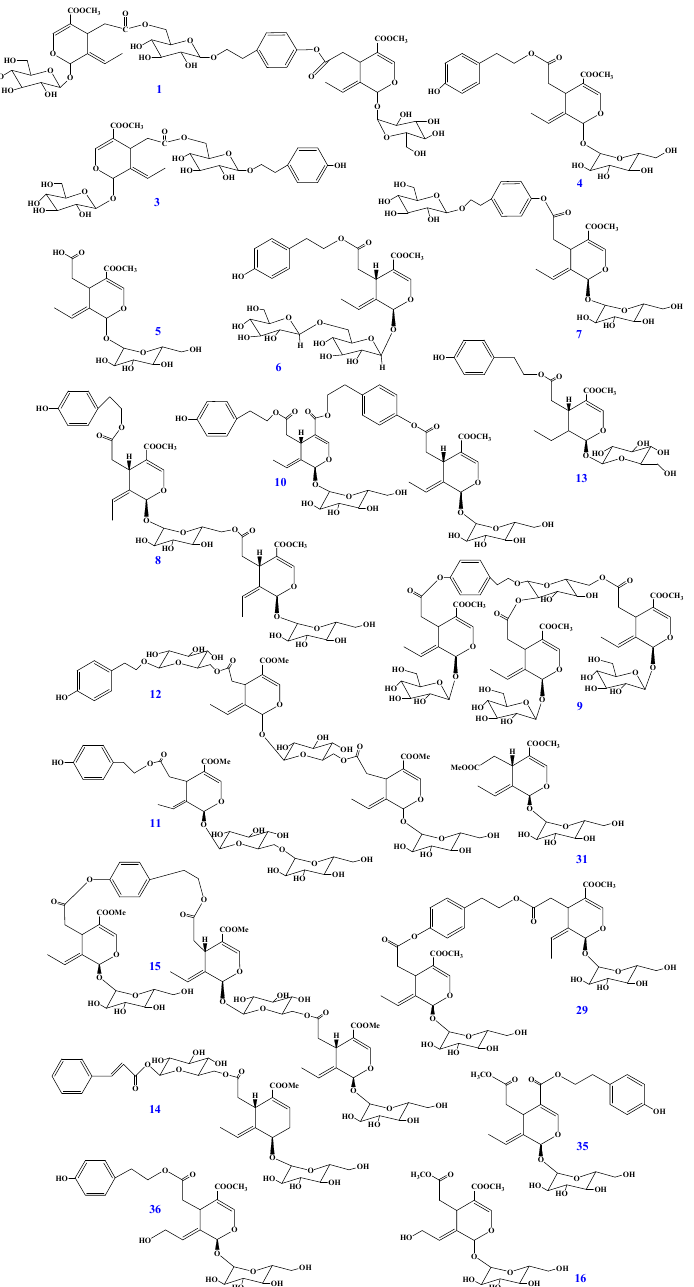
Figure 1. Chemical structures of secoiridoids in F. mandshurica seeds.